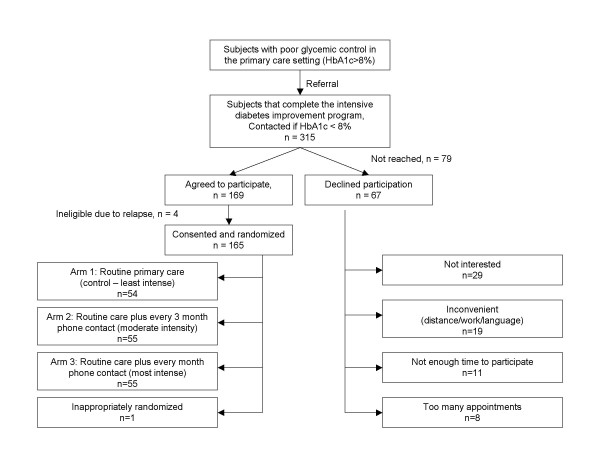
Enrollment and Randomization.